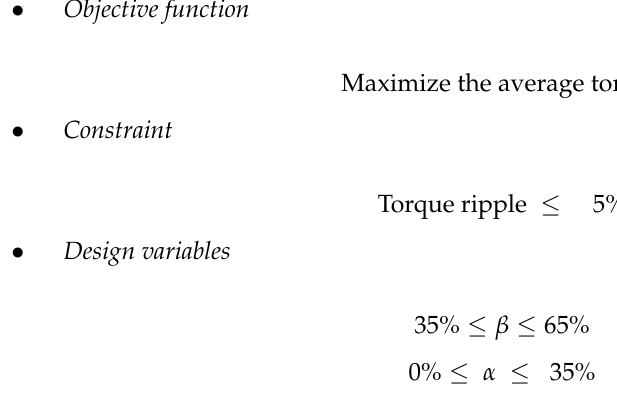
Figure 20. Flowchart for genetic algorithm.